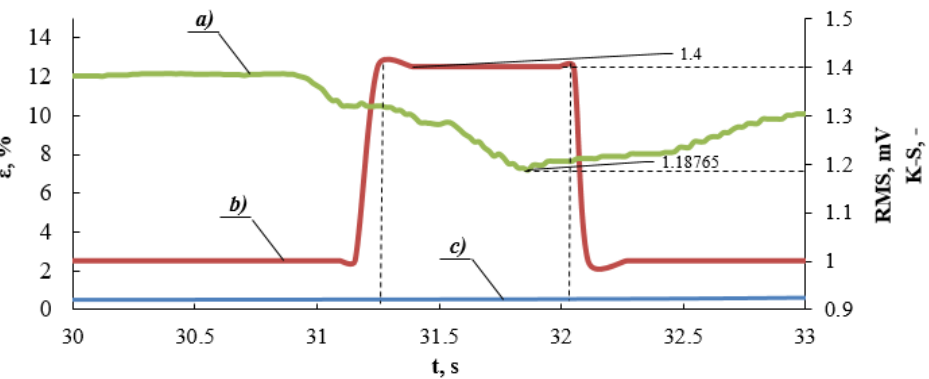
Figure 12. Diagram of ( a ) metric entropy K-S, ( b ) value of effective electrical signal RMS, ( c ) deformation ε as a function of time (a part of the tensile diagram—Figure 11).